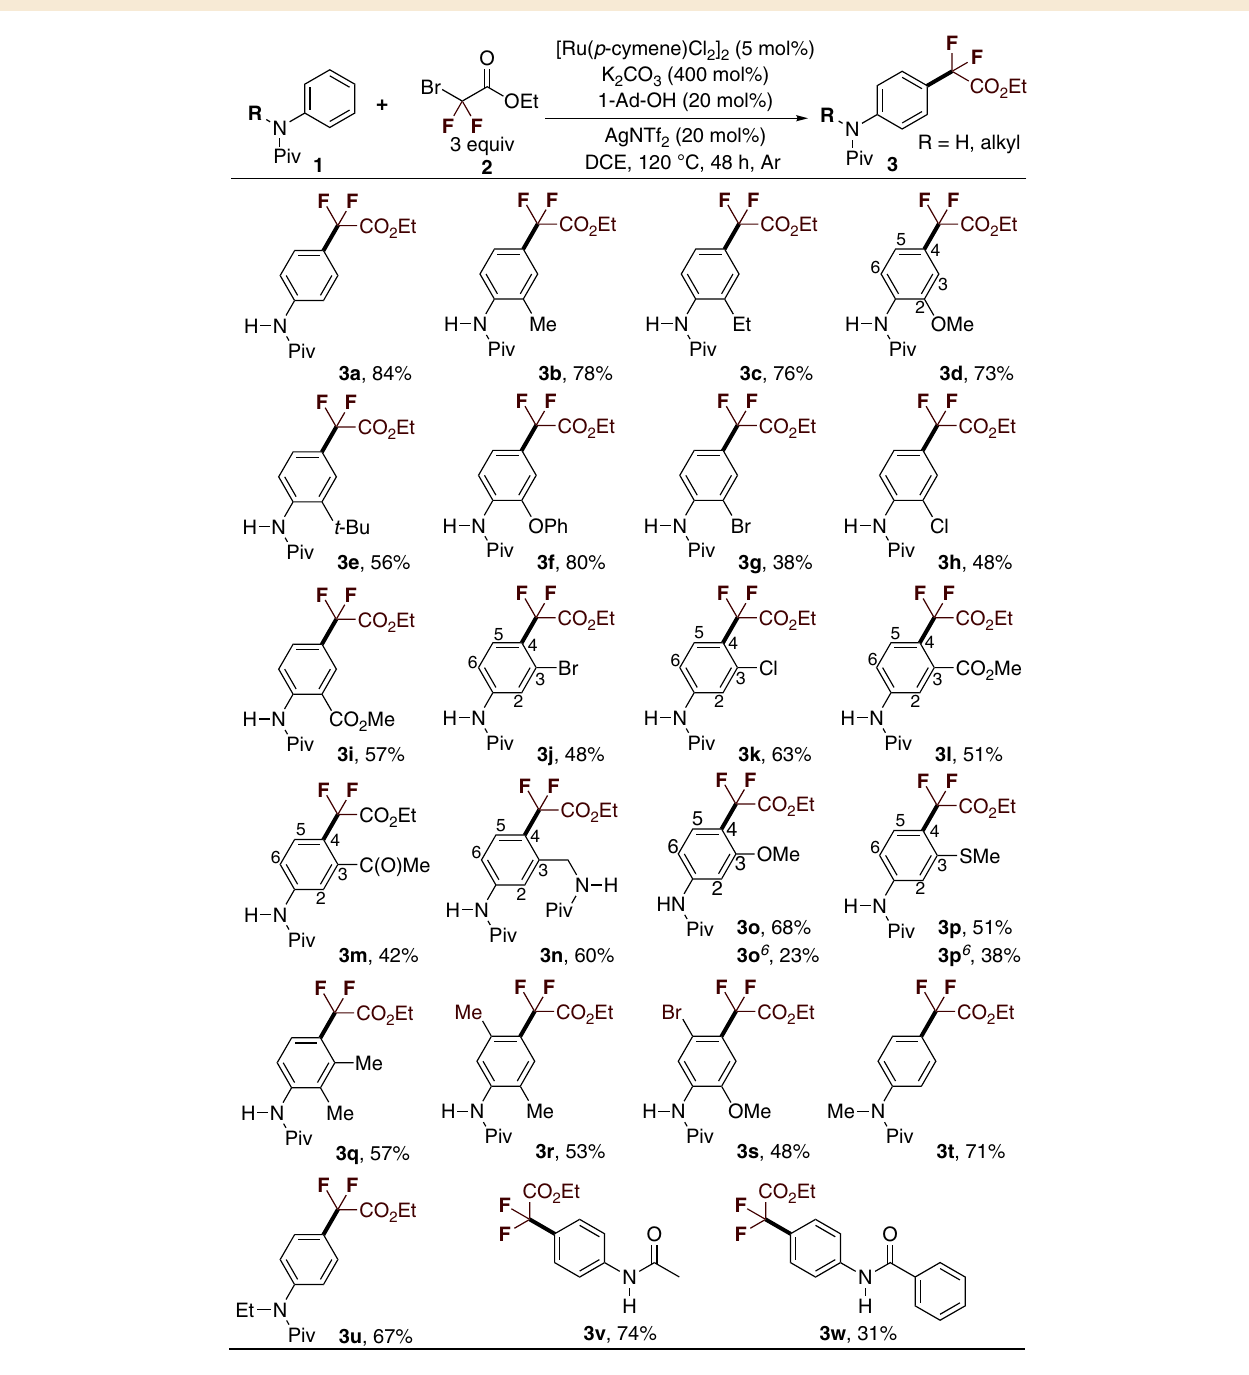
Table 2 Substrate scope of anilides